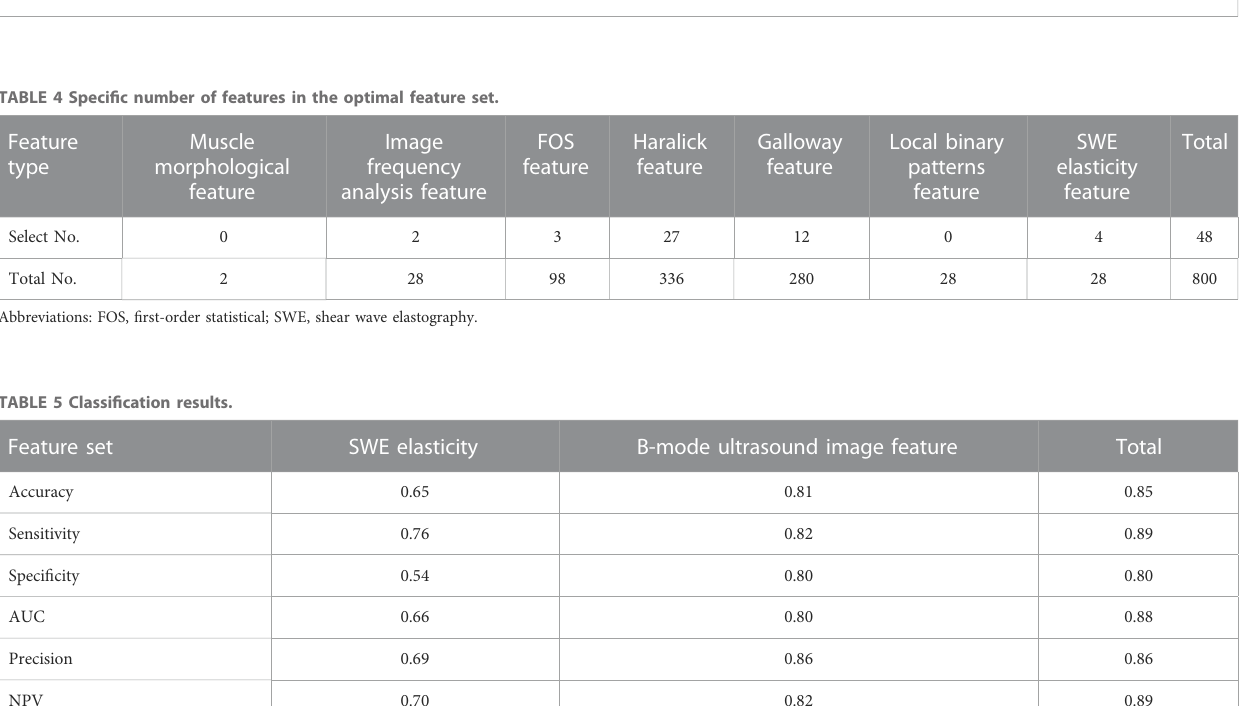
FIGURE 4 The performance of feature selection with different values of the percentile parameter.